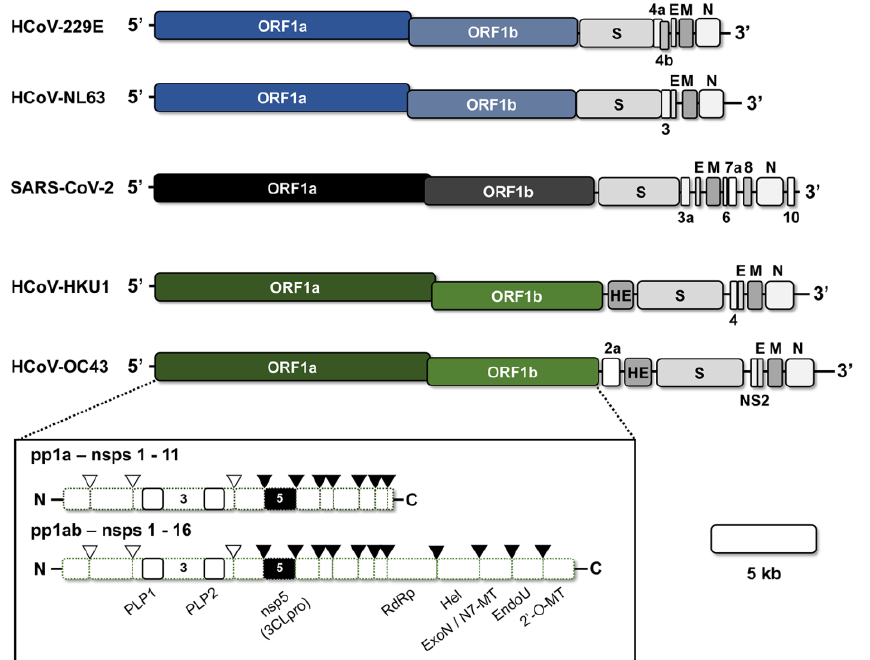
Figure 2. Genomic Organization of the Human Common Cold Coronaviruses and SARS-CoV-2. The genomes of alphacoronaviruses (blue) HCoV-229E and HCoV-NL63 and betacoronaviruses (black, green) SARS-CoV-2, HCoV-HKU1, and HCoV-OC43 are shown with open-reading frames (ORFs) labeled. A 5-kb scale bar is provided. The replicase polyproteins (pp1a and pp1ab) are shown in the box below and the maturation cleavage events mediated by the papain-like proteases (PLPs) and 3CLpro are indicated by the clear or black arrows. E, Envelope; M, Matrix; N, Nucleocapsid; S, Spike; RdRP, RNA-dependent RNA polymerase; Hel, Helicase; ExoN, Exonuclease; N7-MT, N7-methyl- transferase; EndoU, Endonuclease; 2 ′ -O-MT, 2′ O-methyltransferase.